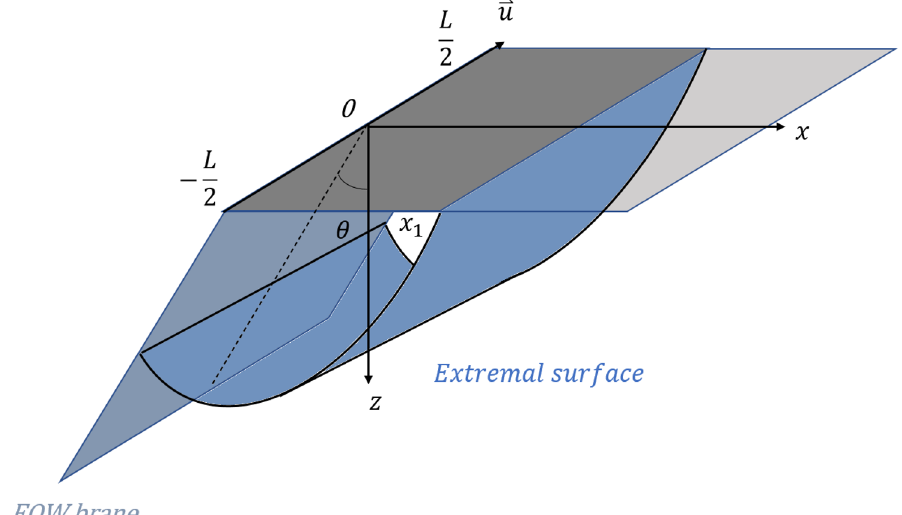
Figure 11 . Strip interval (deep grey region) in